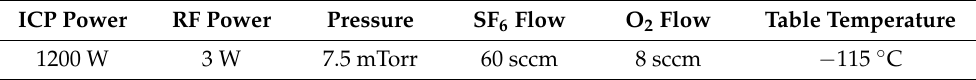
Table 1. Cryogenic process